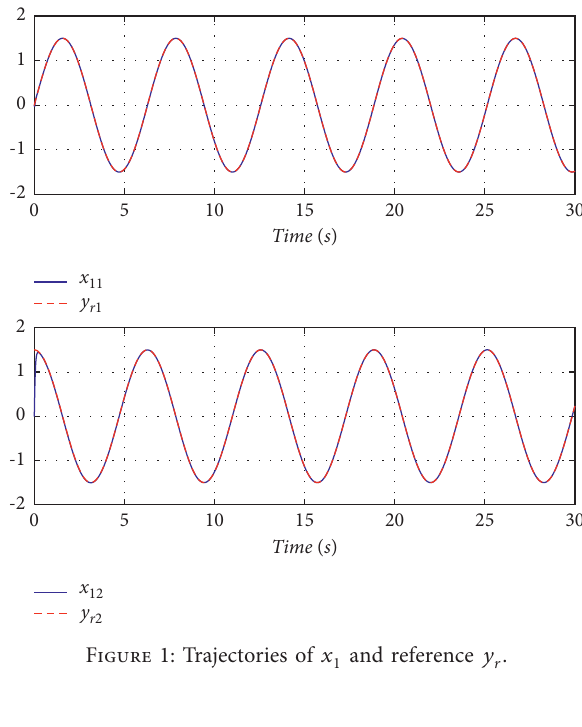
and reference y r 1